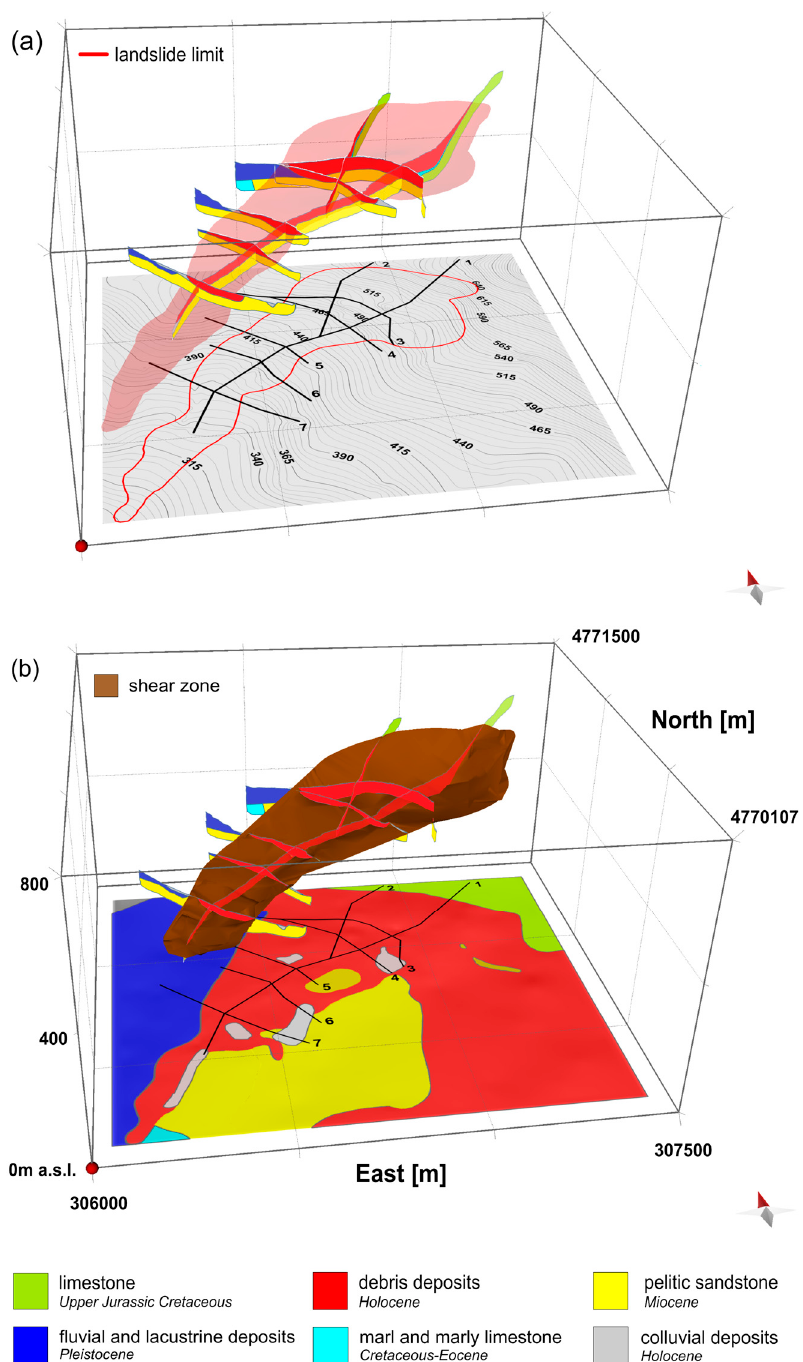
Figure 2. 3D view of geo-lithological data. Cross-sections of Ivancich area and the related traces are reported in the maps of panel ( a ) and ( b ) as black lines; ( a ) Contour of topographic map: the red line and the red shaded area indicate the boundaries and the area of the landslide, respectively; ( b ) Geological map: the brown surface represents the shear zone. In the legend we report the different lithologies of the cross section and geological map.